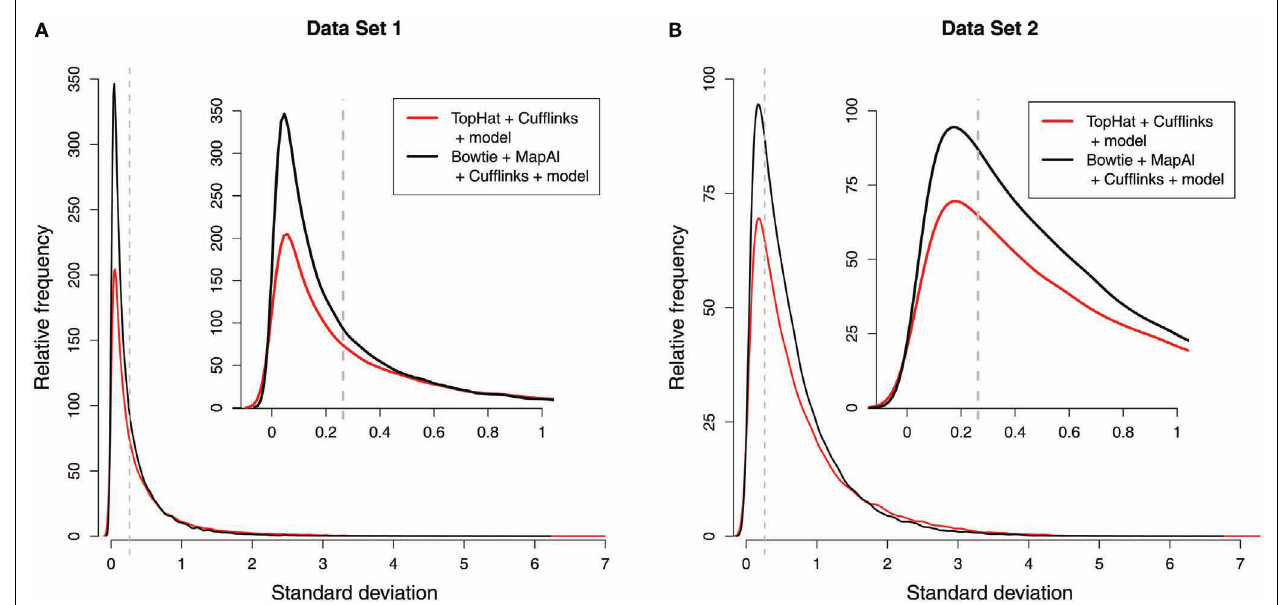
represents the number of splice forms that could be measured with a certain precision (scaled to an arbitrary unit allowing a comparison across samples). The first panel displays results for Data Set 1 [ (A) technical replicates], the second panel is for Data Set 2 [ (B) biological replicates].